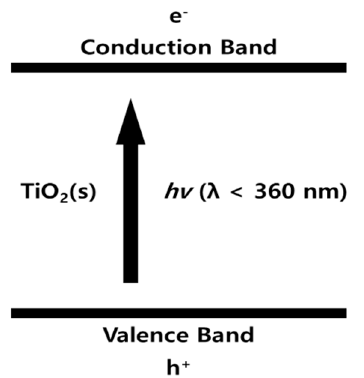
Scheme 1. Band energy structure of a typical solid state semiconductor, TiO 2 .